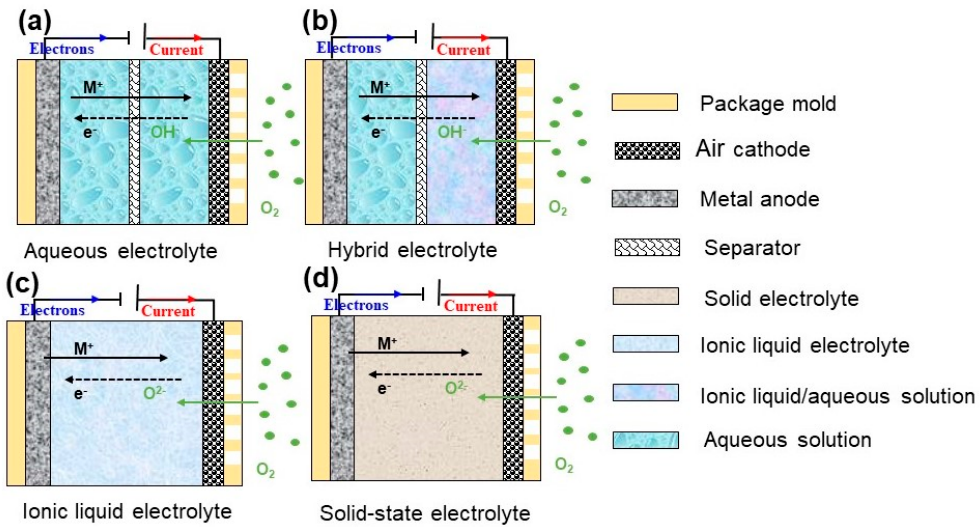
Figure 13. Schematic diagrams of various electrolytes of MABs.